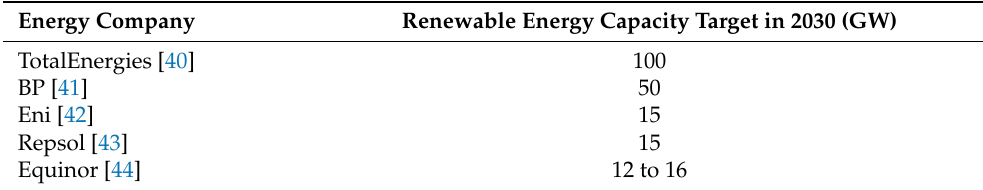
Table 2. Renewable energy targets for European energy